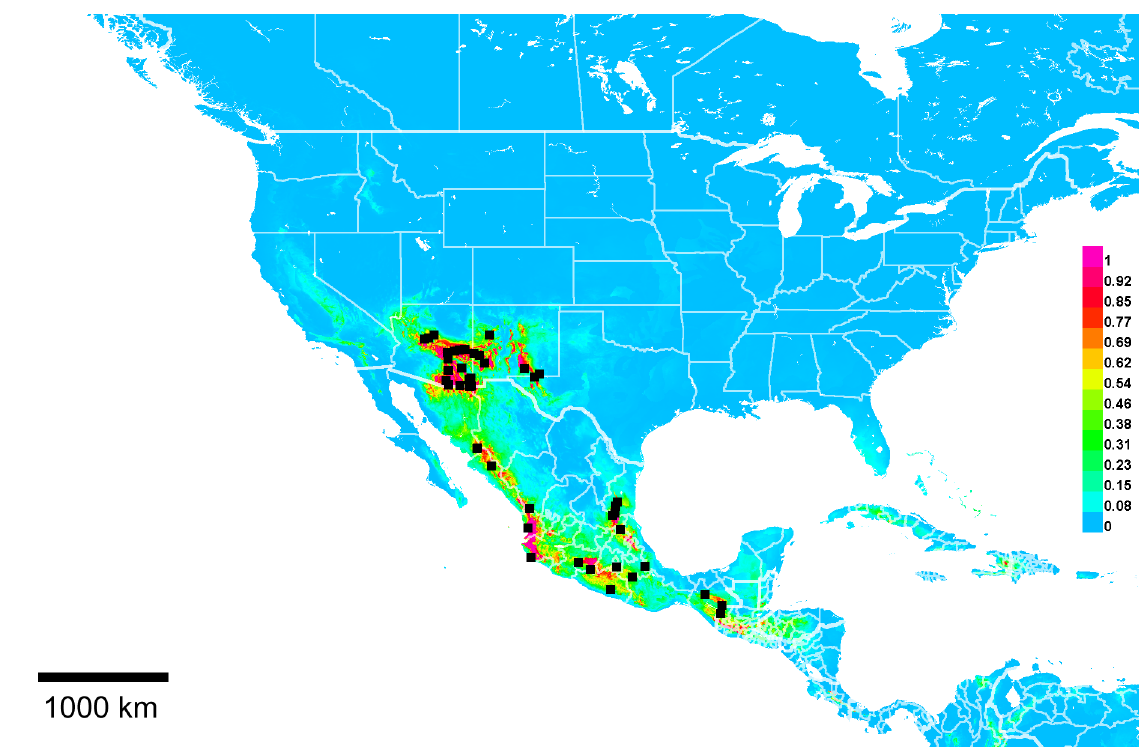
Fig. 35. Georeferenced collection records of Lasioglossum ( D .) holzenthali sp. nov. (black squares) and predicted distribution by maximum entropy ecological niche modelling in Maxent (colour shading). Warmer colours indicate higher cloglog probability of